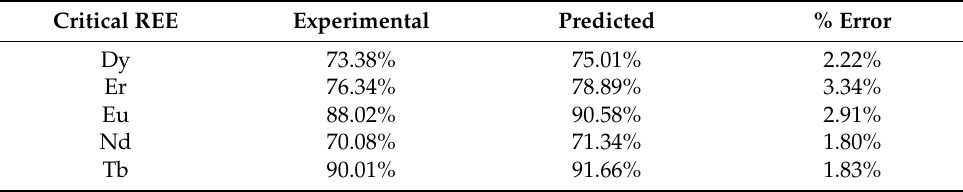
Table 13. Comparisons between experimental and predicted results at the optimum